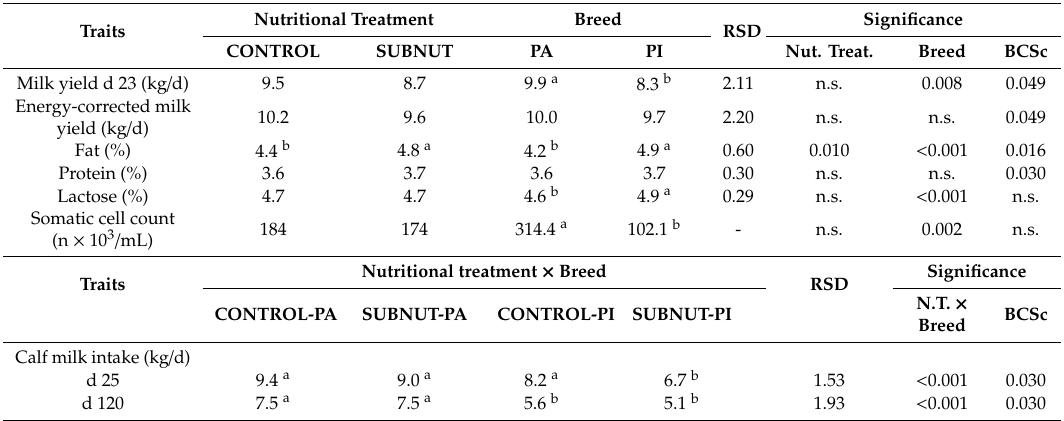
Table 6. Cow milk yield and composition, and calf milk intake, according to the nutritional treatment, the breed or their interaction (cow BCS at calving included as a